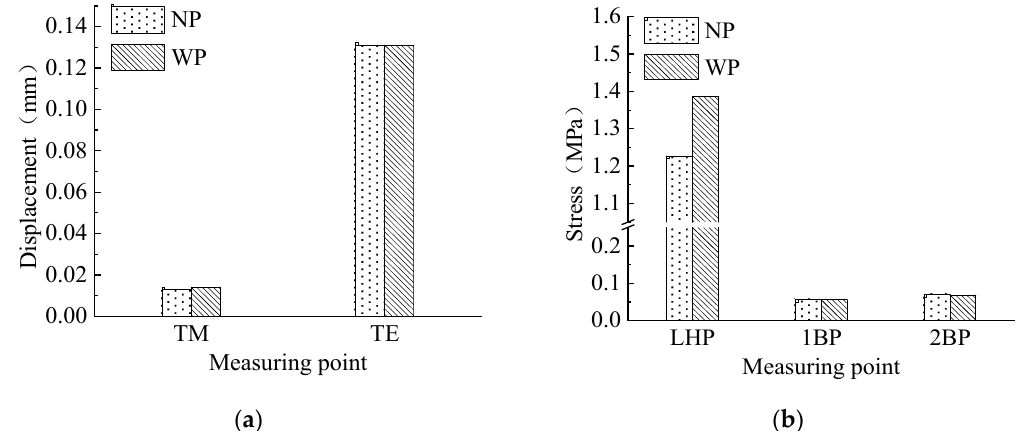
Figure 10. Stress and displacement in the hoisting period of construction. ( a ) Displacement and ( b ) stress.